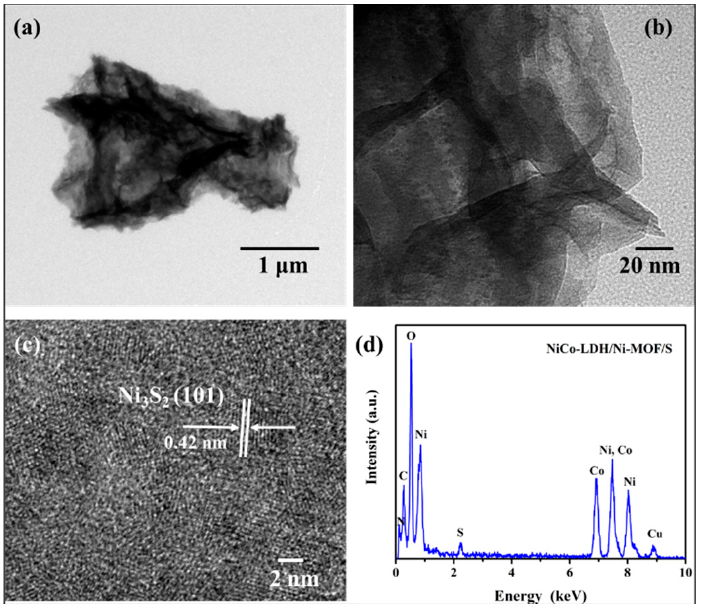
Figure 2. ( a ) Low magnification TEM images of CC/NiCo LDH/S-Ni MOF, ( b ) high-resolution TEM (HRTEM) image, ( c ) HRTEM image of the crystalline region, ( d ) The EDS spectrum of the CC/NiCo LDH/S-Ni MOF product.